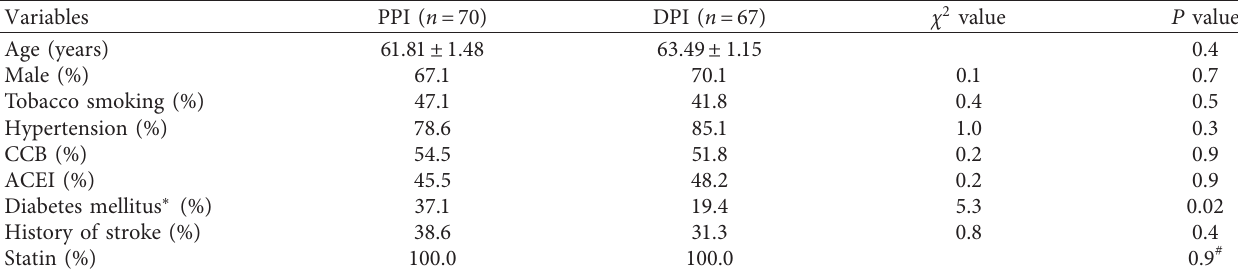
Table 1: Demographic data and medical history of study participants, number (%).